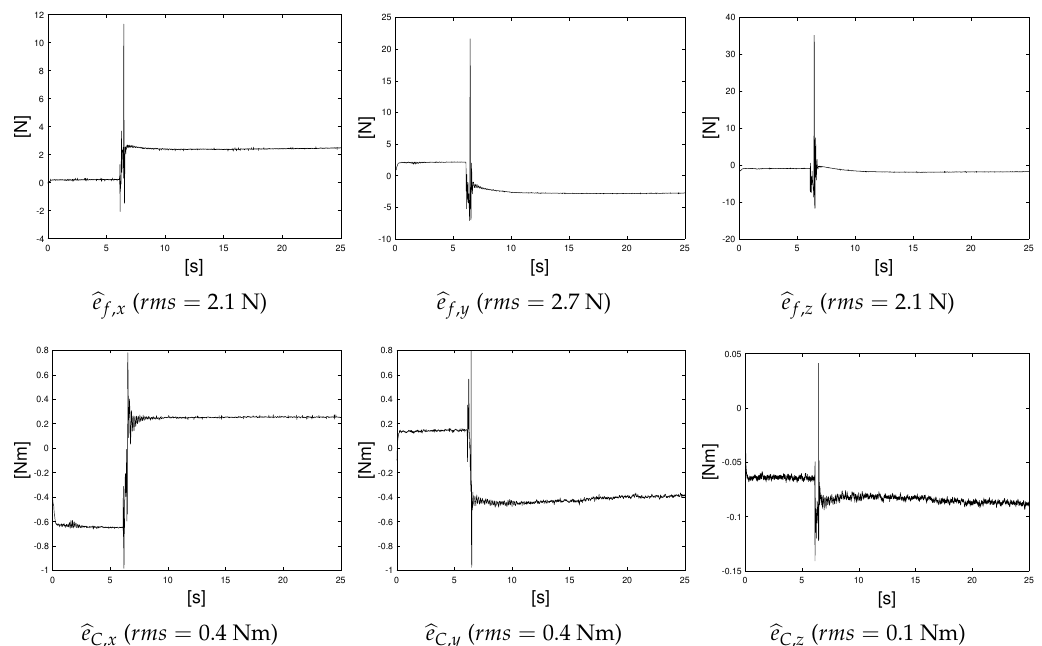
Figure 13. Estimated interaction forces (cid:98) e f and torques (cid:98) e C errors for the #2 experimental